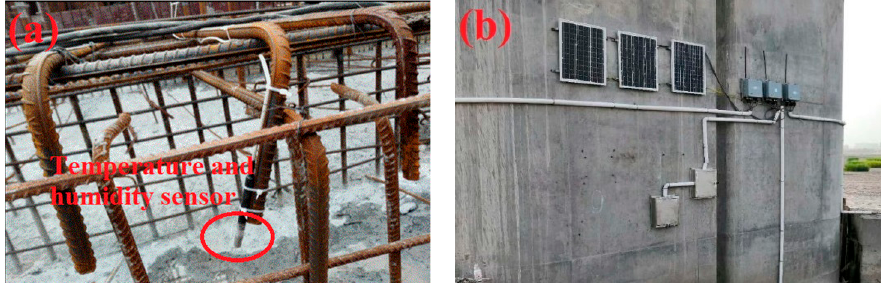
Figure 9. Sensor and apparatus. ( a ) Temperature and humidity sensor; ( b ) Wireless transportation apparatus (with solar panel).